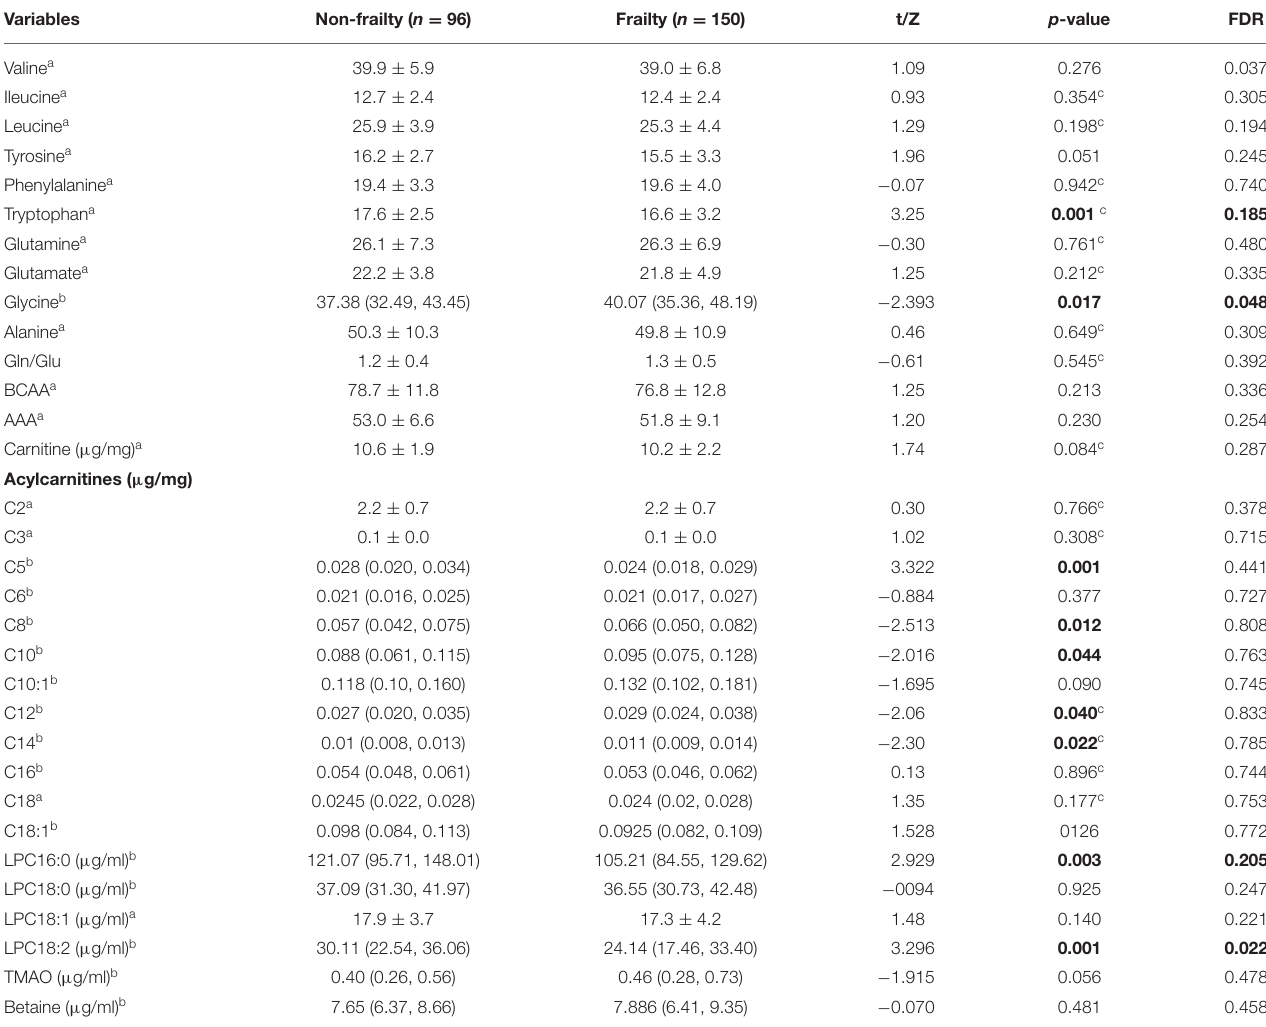
TABLE 2 | Serum concentrations of metabolites in participants with and without frailty.